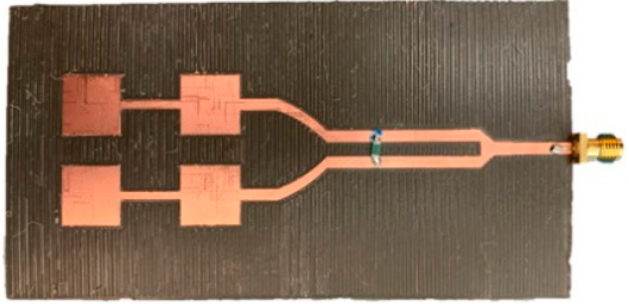
Figure 8. Fabricated two-by-two series-fed patch array with one-by-two Wilkinson power divider.